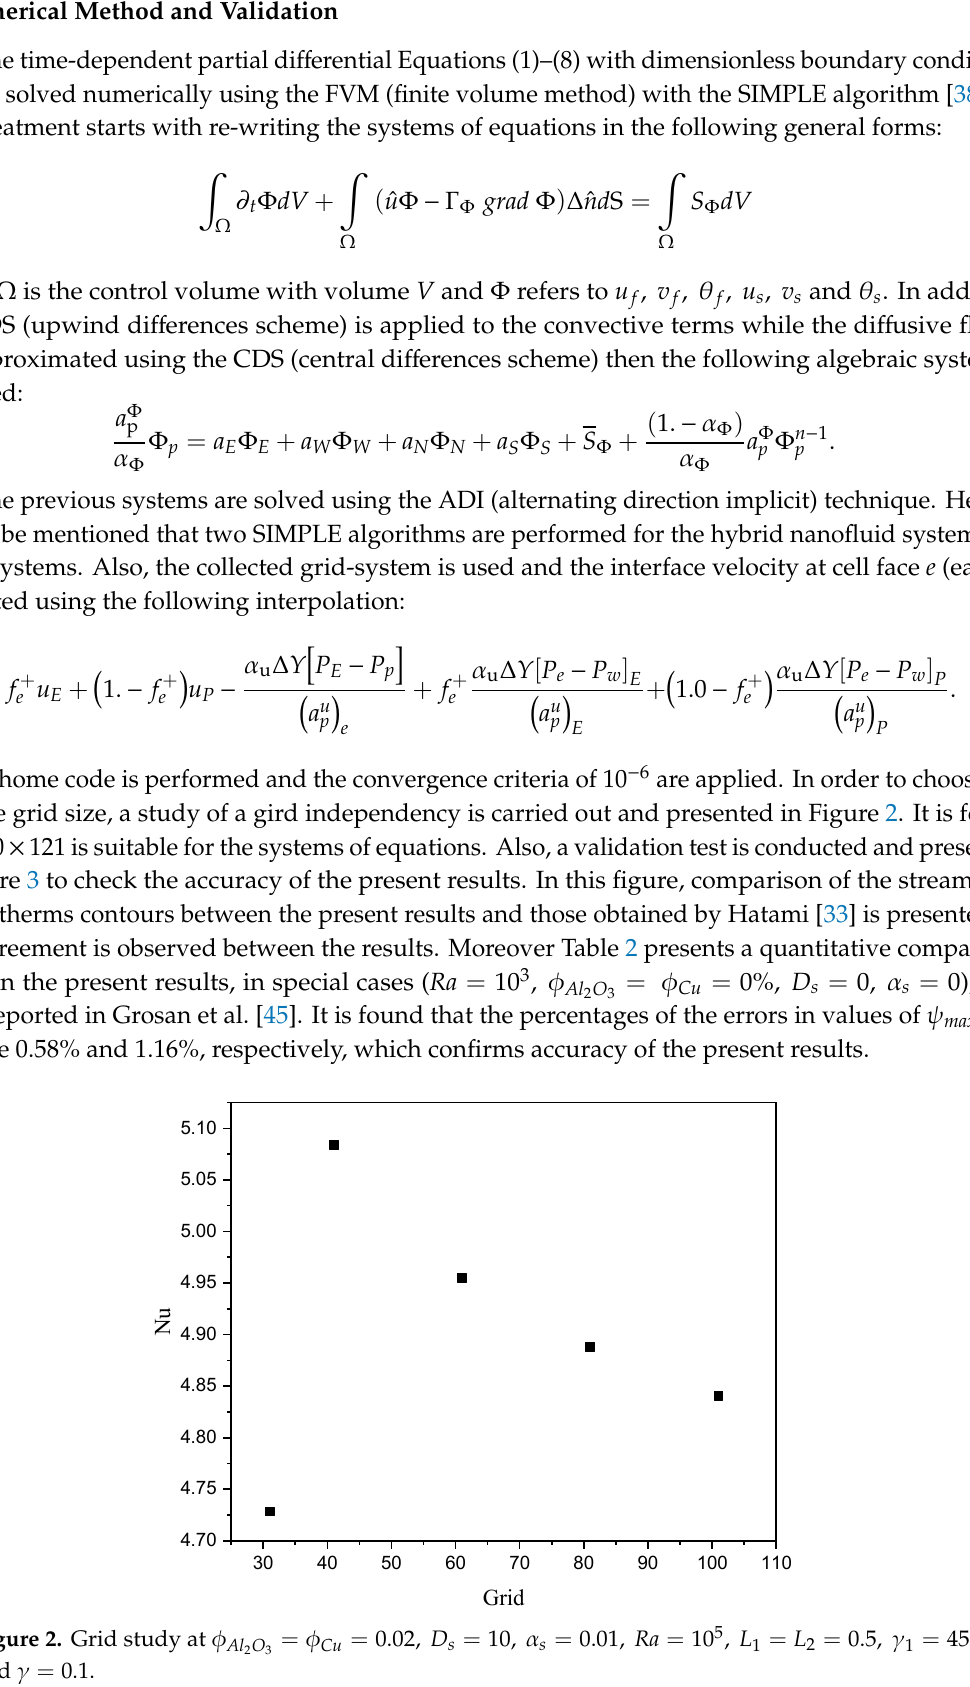
= φ = 0.02, D s = 10, α s = 0.01, Ra = 10 5 , L = 𝜙 (cid:3004)(cid:3048) = 0.02, 𝐷 (cid:3046) = 10, 𝛼 (cid:3046) = 0.01, 𝑅𝑎 = 10 (cid:2873) , 𝐿 (cid:2869) = 𝐿 (cid:2870) = 0.5, 𝛾 (cid:2869) = 45, Cu (cid:3118) (cid:3016) (cid:3119) 2 O 3